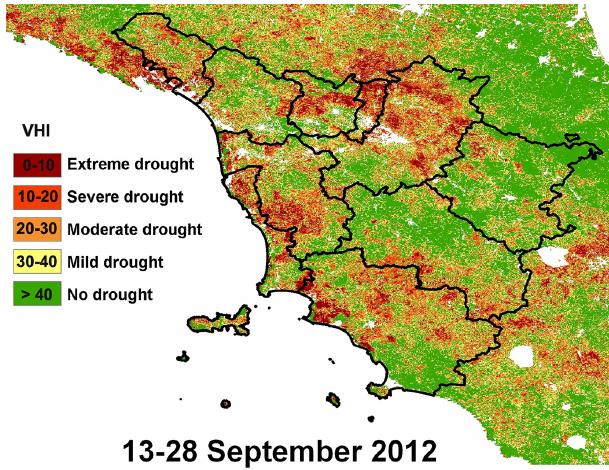
Figure 2. Vegetation Health Index (VHI) referred to the bi-weekly period 13–28 September